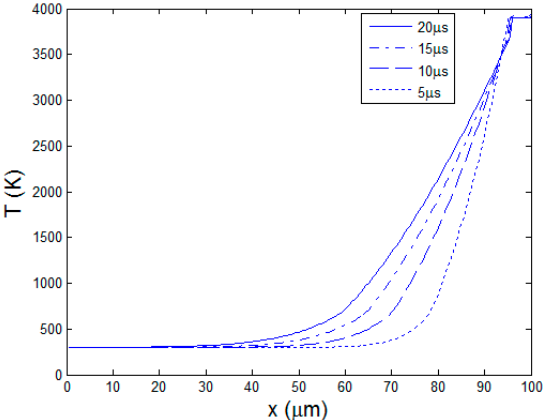
Figure 9. Temperature curves at the end of different pulse lengths.